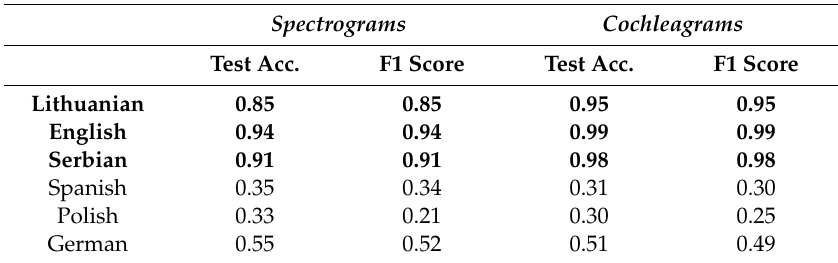
Table 5. Classification test results for spectrograms and cochleagrams: Lithuanian, English, and Serbian datasets are used for training. The datasets that were used in the training process are highlighted in bold font.